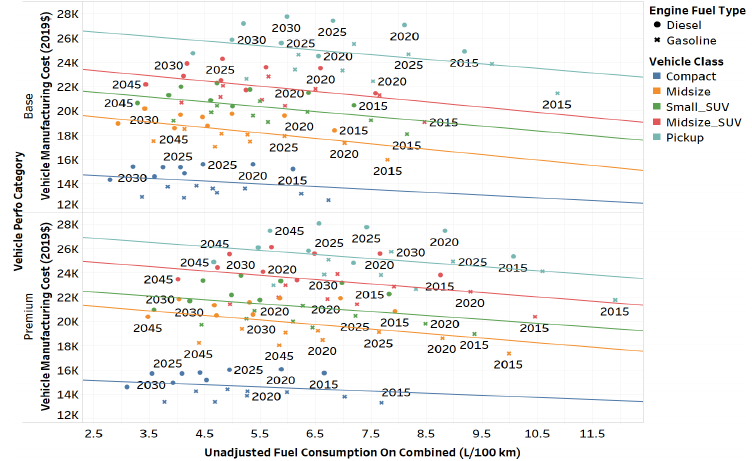
Figure 14. Manufacturing cost versus fuel consumption of conventional vehicles.